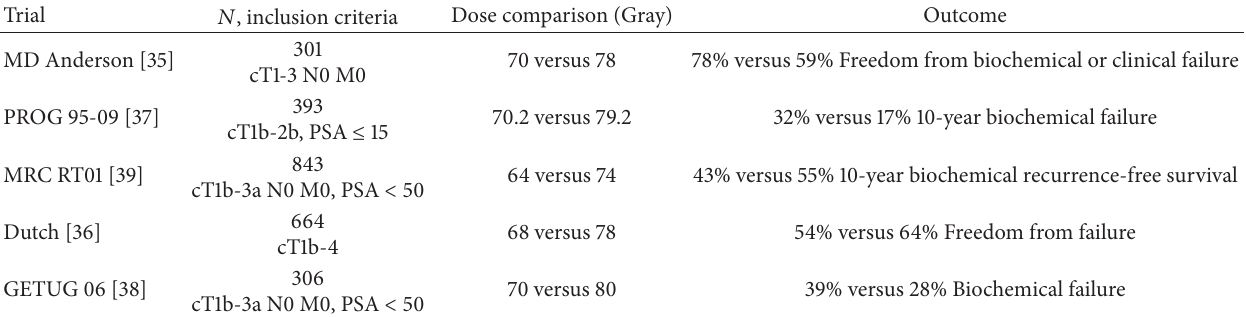
Table 1: Randomized controlled trials evaluating the efficacy of radiation dose escalation for prostate cancer.